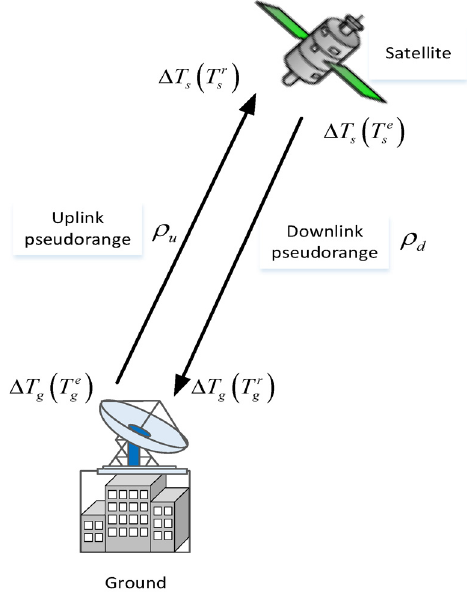
Figure 1. Schematic diagram of satellite-ground time synchronization.